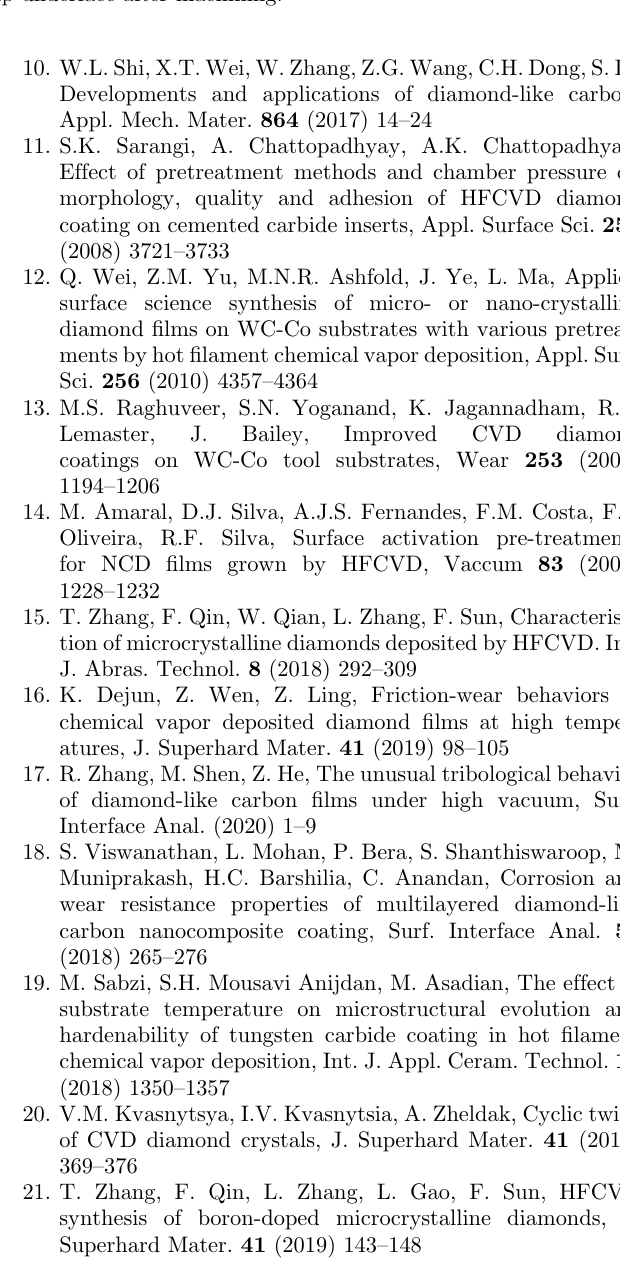
Fig. 20. SEM images of chip underface